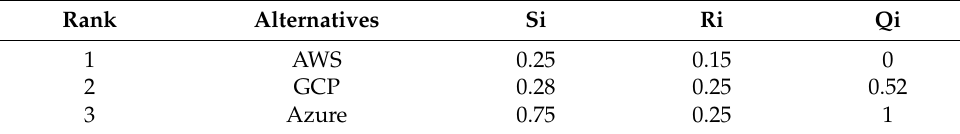
Table 2. Scenario 1: Temporary